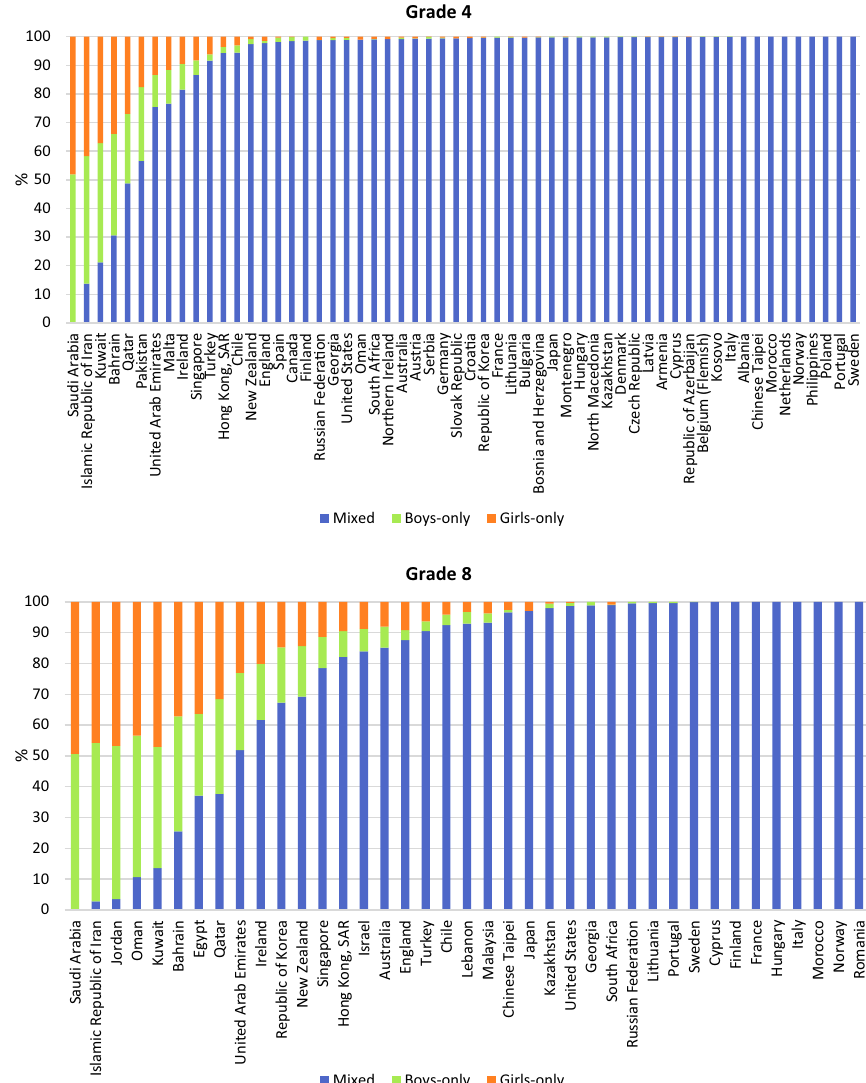
Fig. 1 Distribution of students in single‑gender or mixed education among countries participating in TIMSS